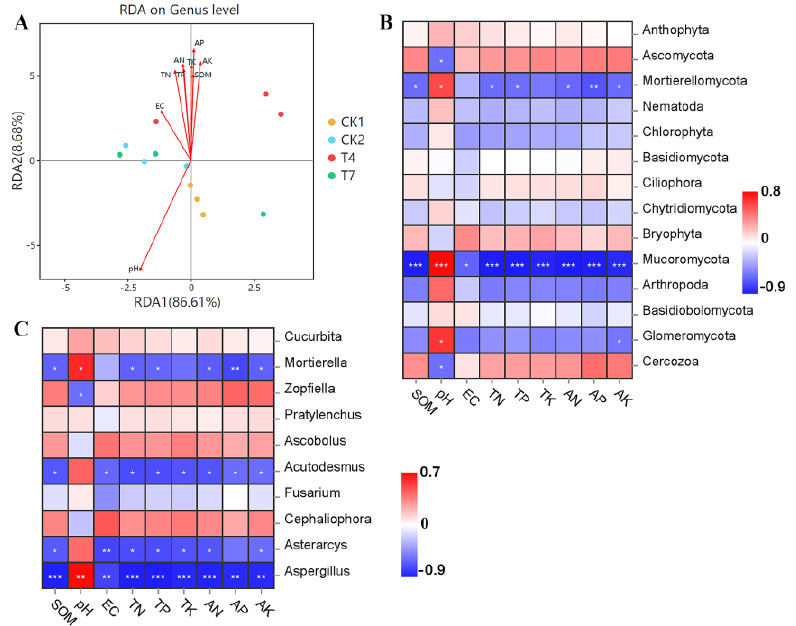
Figure 10. Redundancy analysis (RDA) of soil chemical properties and bacterial communities. ( A ) Phylum level ( B ) and genus level ( C ) bacterial dominant flora and soil environmental factors: Pearson correlation analysis; SOM, soil organic matter; EC, electrical conductivity; TN, total nitrogen; TP, total phosphorus; TK, total potassium; AN, hydrolyzable nitrogen; AP, available phosphorus; AK, available potassium. (The horizontal axis indicates environmental factors, the vertical axis indicates species, and colors from blue to red represent the relative abundance of the functions from low to high; *: significant correlation, p < 0.05; **: highly significant correlation, 0.001 < p < 0.01; ***: highly significant correlation, p <